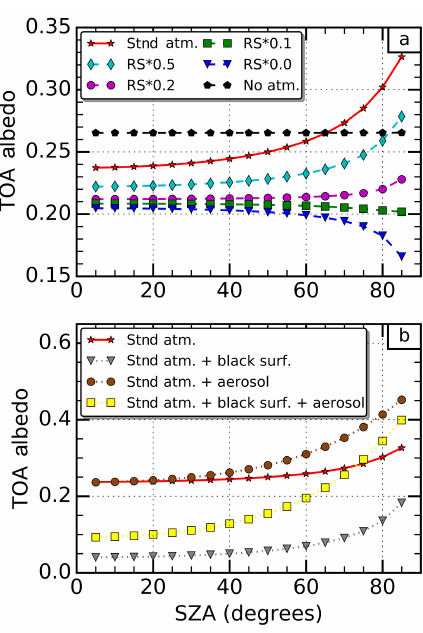
Figure 5. Simulation of top-of-atmosphere (TOA) albedo as a func- tion of solar zenith angle (SZA). The dashed lines (a) represent at- mospheres where a scaling factor has been applied to the Rayleigh scattering (RS). The dotted lines (b) represent atmospheres where either aerosols are included, or the surface albedo is set to zero (black surf.), or both. The solid red line with star marker appearing in both plots represents the standard atmosphere (Stnd. atm.) with no modifications. All simulations assume a US62 standard atmo- sphere over a Lambertian vegetated surface unless otherwise stated. When aerosols are included, their optical depth is set to 1 at 550nm and their optical properties are typical of rural aerosols. Details of the aerosol optical properties and the tool used to perform these calculations, the Discrete Ordinate Radiative Transfer (DISORT) model Santa Barbara DISORT Atmospheric Radiative Transfer, are given by Ricchiazzi et al. (1998).